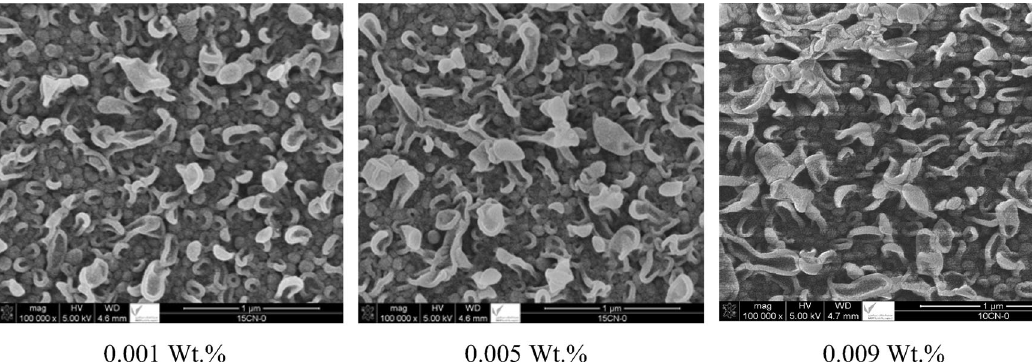
Fig. 8 SEM images of MWCNT–COOH in MPD